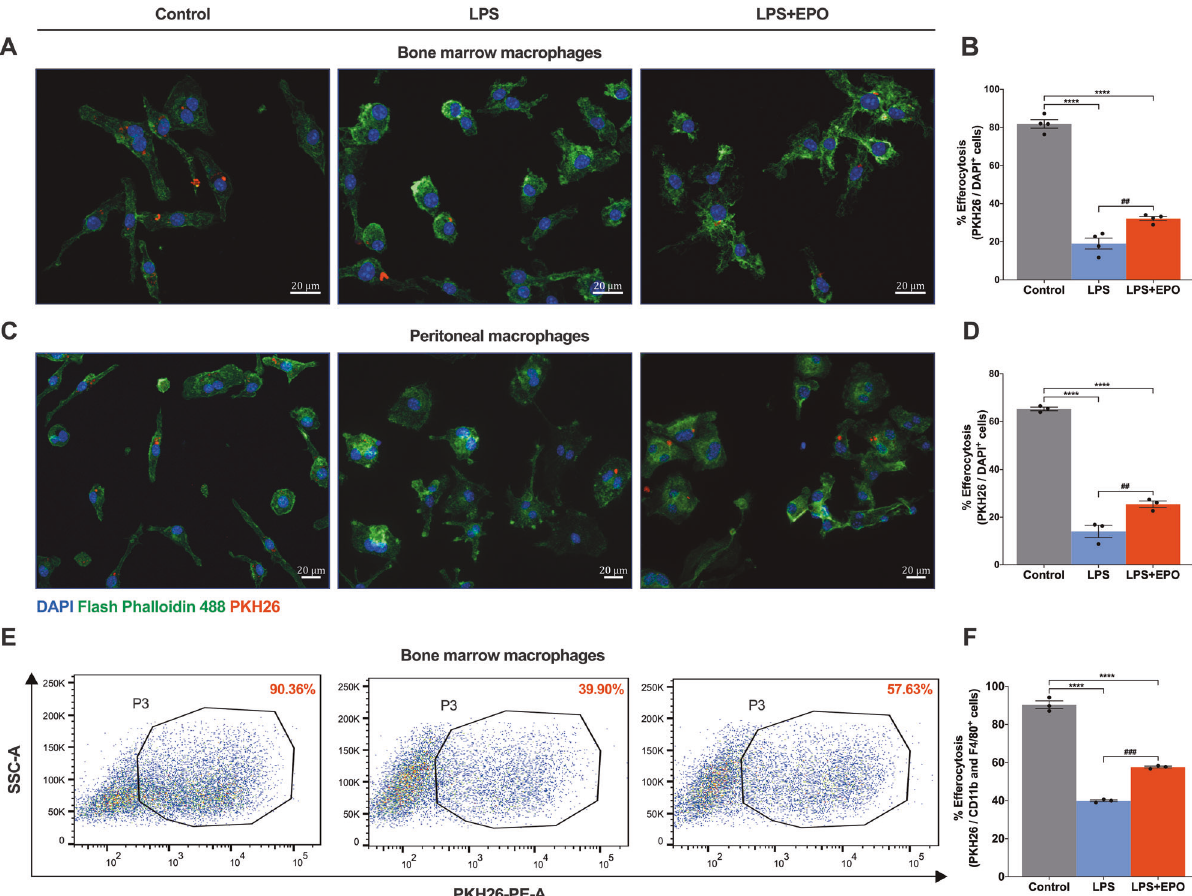
Fig. 7 EPO treatment enhances M2 phenotype macrophage efferocytosis of apoptotic SNSCs, ex vivo. IF staining of BMMØs ( A ) and PMØs ( C ) (Flash phalloidin, green) shows that LPS + EPO treatment signi fi cantly enhances efferocytosis of apoptotic SNSCs (PKH26, red) as compared to LPS treatment and the results are mentioned in the bar graph ( B , D ). In the BMMØs study, each image represents fi ve images from four independent experiments, a total of 20 images/group. In the PMØs study, each image represents fi ve images from three independent experiments, a total of 15 images/group. The percent efferocytosis was calculated using PKH26 positivity per cell (DAPI). Scale bar, 20 μ m; magni fi cation, 40x. One-way ANOVA, Tukey ’ s multiple comparisons test. Data were expressed as means ± SEM, **** P < 0.0001, Control vs. LPS and LPS + EPO; ## P < 0.0021, LPS vs. LPS + EPO, n = 4 (BMMØs study), n = 3 (PMØs study). E Flow cytometry data show that LPS + EPO treatment signi fi cantly augments %efferocytosis of apoptotic SNSCs as compared to LPS treatment and the results are mentioned in the bar graph ( F ). One-way ANOVA, Tukey ’ s multiple comparisons test. Data were expressed as means ± SEM, **** P < 0.0001, Control vs. LPS and LPS + EPO; ### P < 0.0002, LPS vs. LPS + EPO, n = 3. Cell Death and Disease (2022)